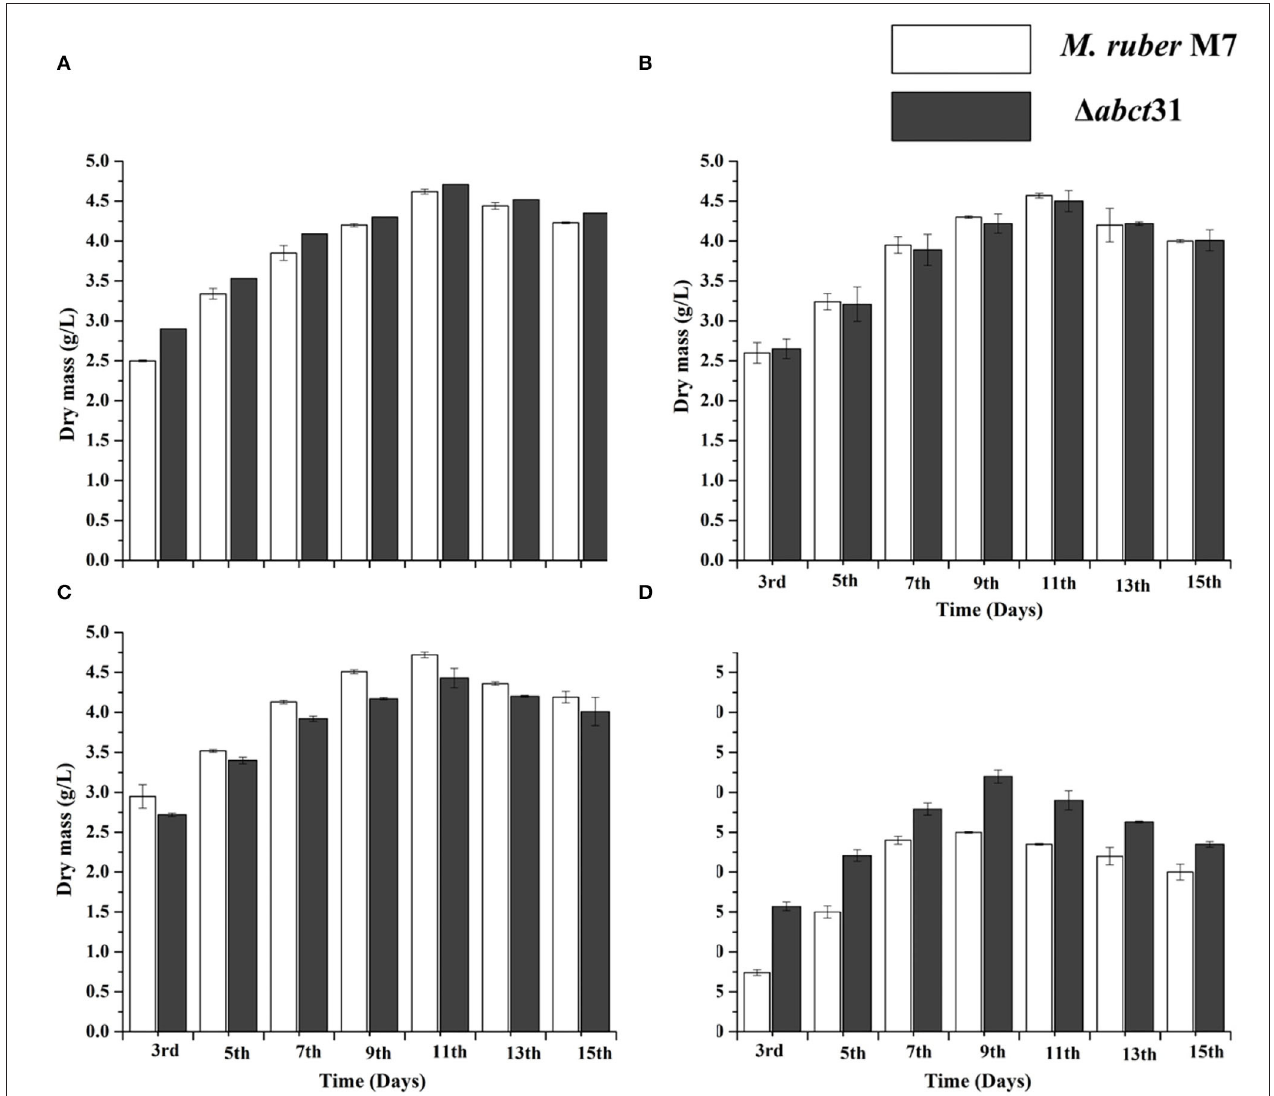
FIGURE 9 | Comparison of biomass (dry cell weight) of the M. ruber M7 and 1 abct 31 against pathway amino acid. (A) PDB medium without amino acid (control); (B) PDB medium with D-valine; (C) PDB medium with phenylacetic acid; (D) PDB medium with L-cysteine, at 2mM concentrations and incubated at 28 ◦ C without agitation. The bar representing the mean of triplicate values and error bars show standard